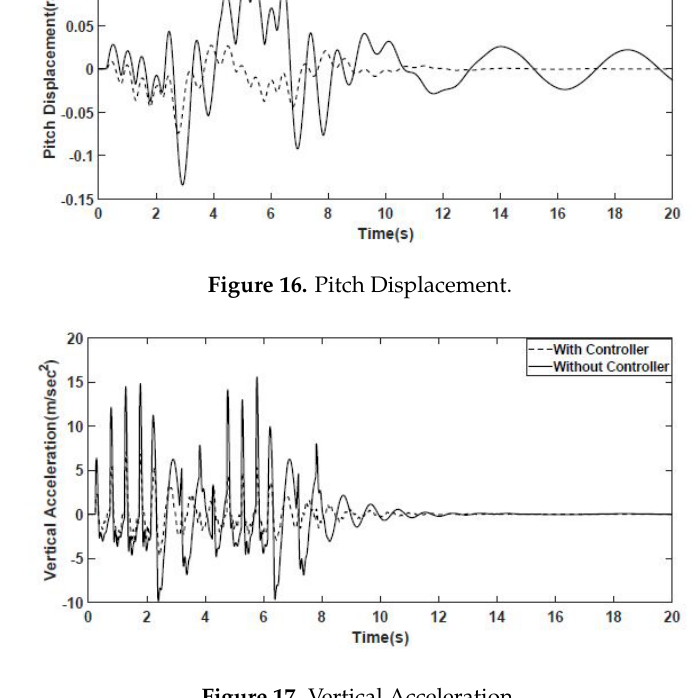
Figure 17. Vertical Acceleration.